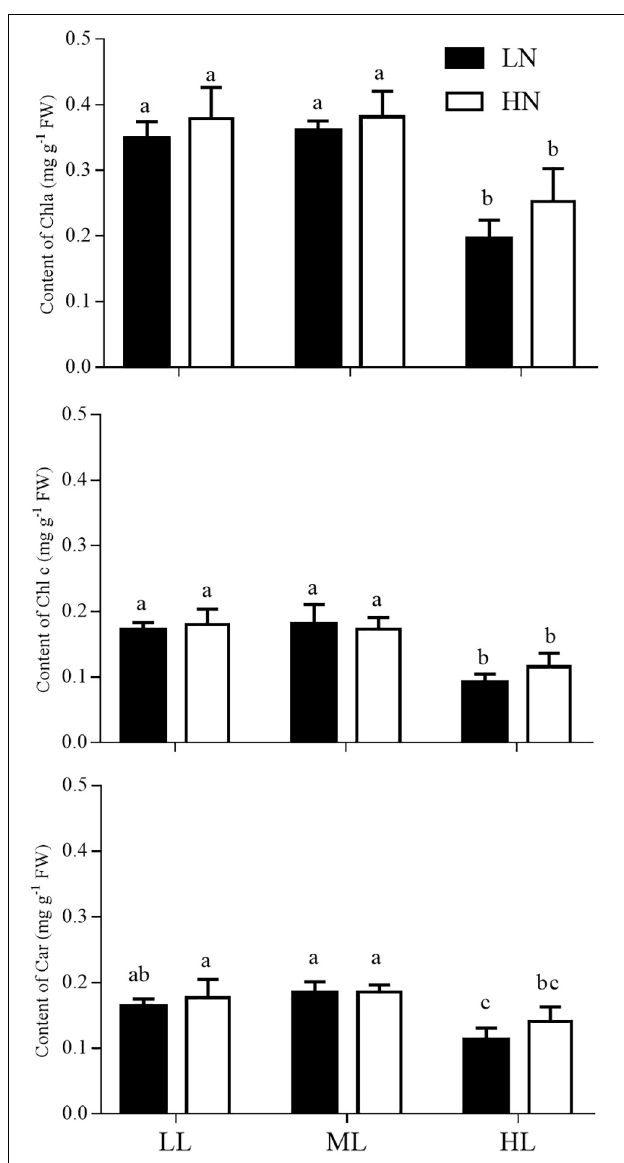
FIGURE 4 | Contents of Chl a, Chl c and Car in S. muticum grown at different light and nitrogen levels for 12 days. Significant ( P < 0.05) differences among the treatments are indicated by different lowercase letters. Vertical bars represent ± SD for the means of three